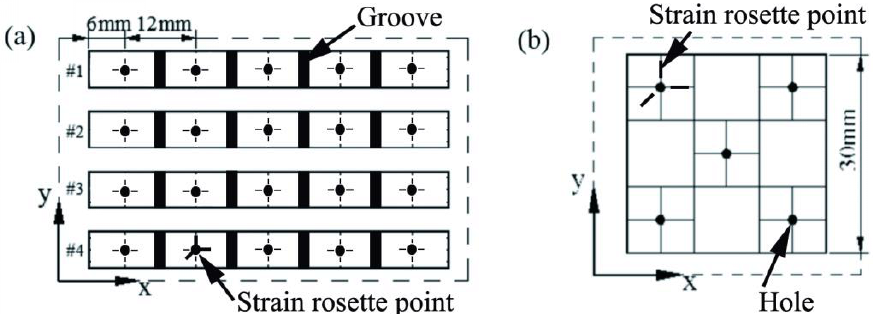
Figure 3. Design model of residual stress testing: ( a ) Residual stress in the direction of length; ( b ) residual stress in the plane distribution.